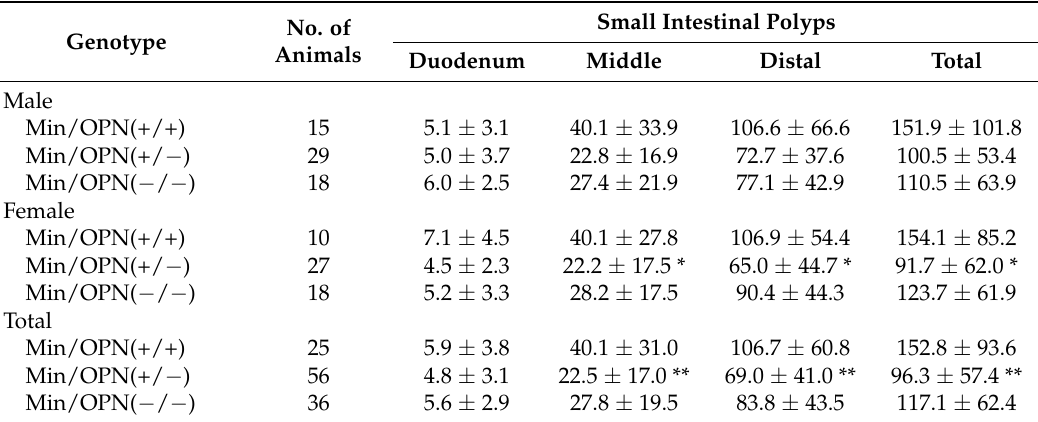
Table 1. Number of small intestinal polyps in osteopontin (OPN)-deficient Min mice.